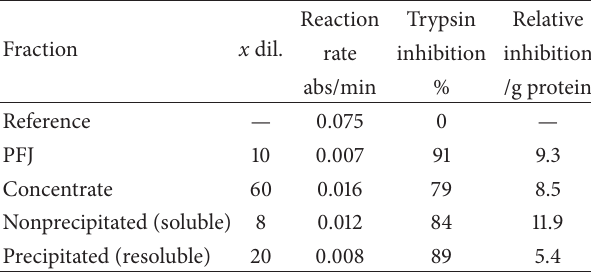
Table 4: Trypsin inhibition activity of native PFJ and processed